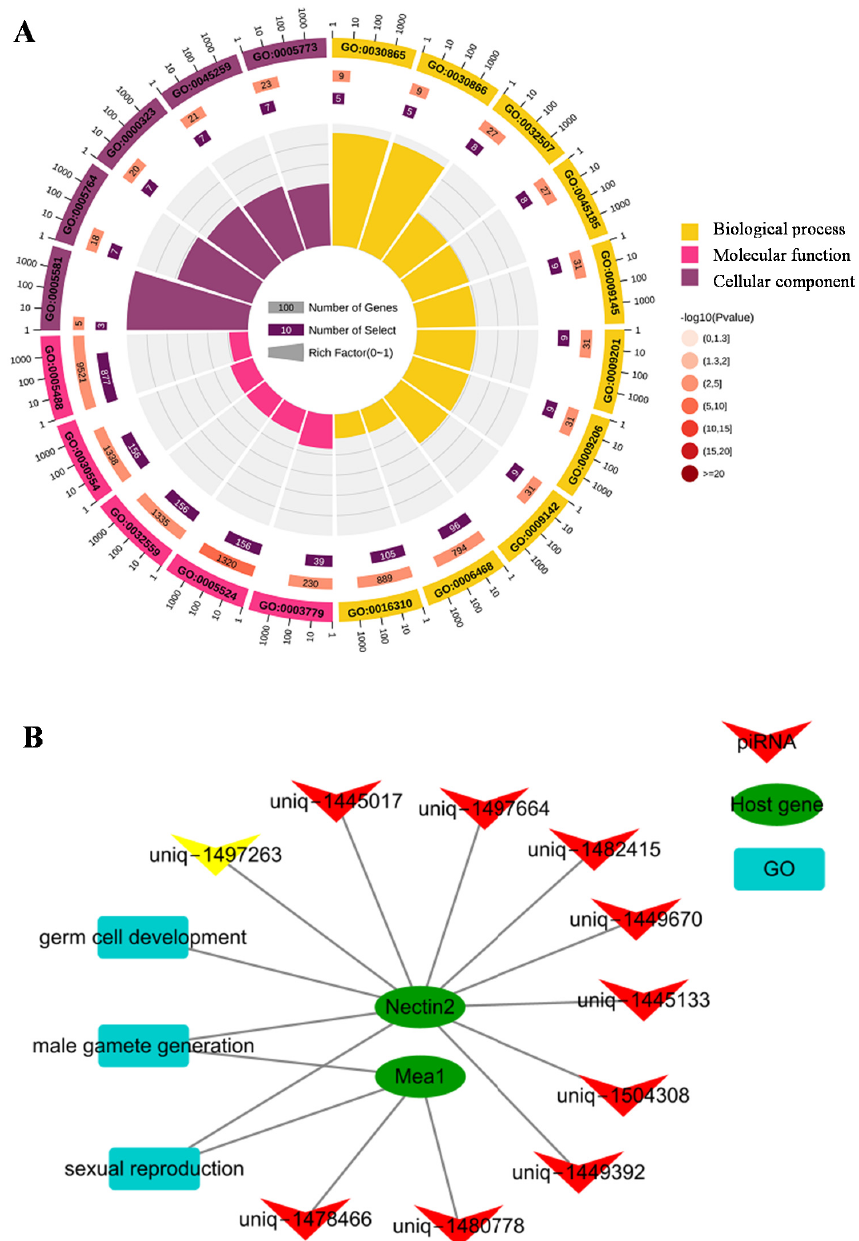
Figure 4. Candidate host-genes for piRNAs. ( A ) GO analysis of candidate host-genes of all putative piRNAs. From outside to inside: the first circle indicates the GO ID (yellow represents biological processes, pink molecular functions, and purple cellular components) and the scale shows the number of genes; the second circle shows the gene number of the GO terms; the third circle shows the number of target genes enriched in each GO term; and the fourth circle indicates the Richfactor value. ( B ) Network showing the relationship between piRNAs, host-genes, and sex-related